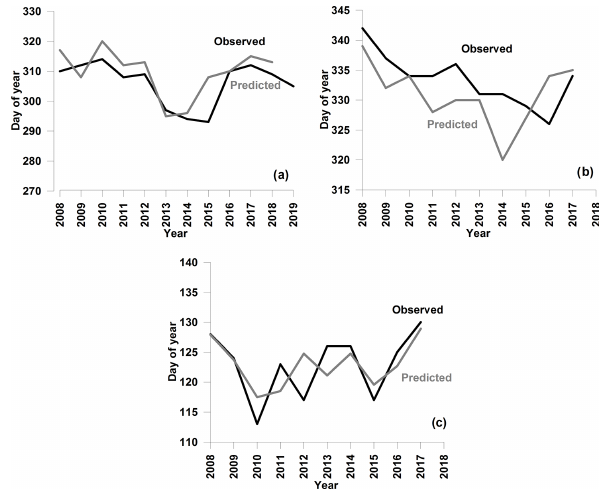
Figure 11. Interannual variability in the ice thickness extracted from 2D ice thickness product at the Pitlar, Gorki and Polnovat sta- tions and the values observed at these gauging stations: (a) maxi- mum ice thickness and (b) ice thickness on 1 December.